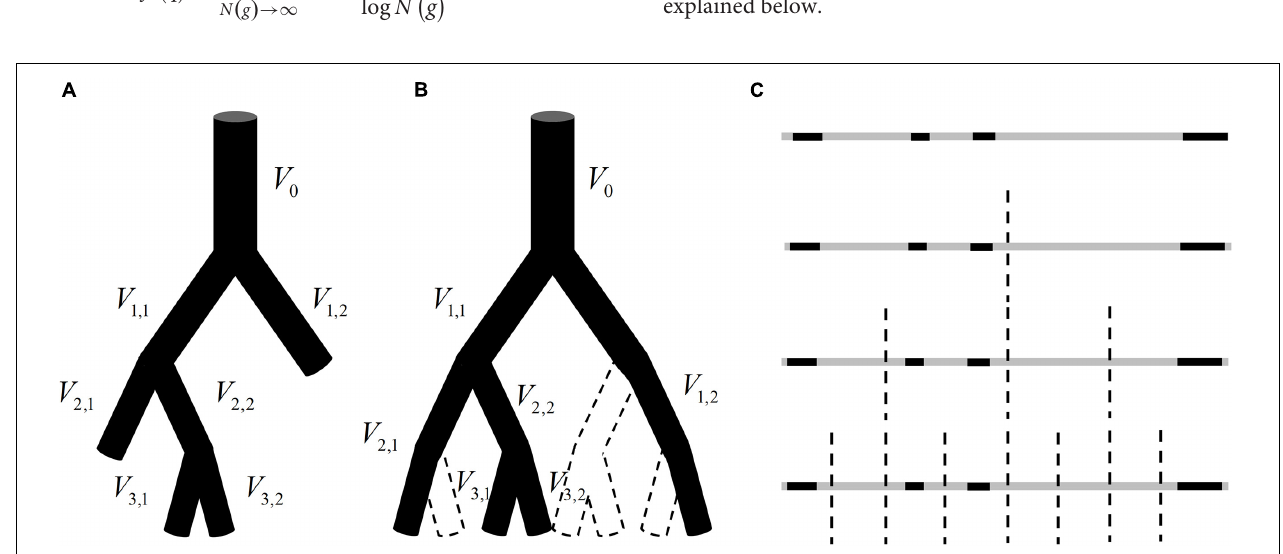
FIGURE 2 | (A) An instance of a vascular tree with the maximal generation of 3. (B) A hypothetical perfect binary tree for the vascular tree in panel (A) and there is no blood flow in the vessel segment surrounded by dotted lines. (C) The analogy of the blood flow distribution in panel (B) to a one-dimension graph.